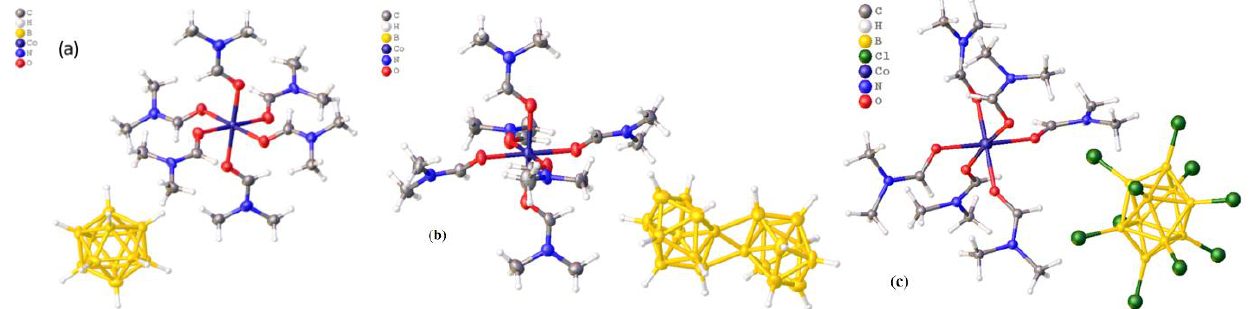
Figure 1. Structures of samples ( a ) 1 ; ( b ) 2 ; ( c ) 3 .